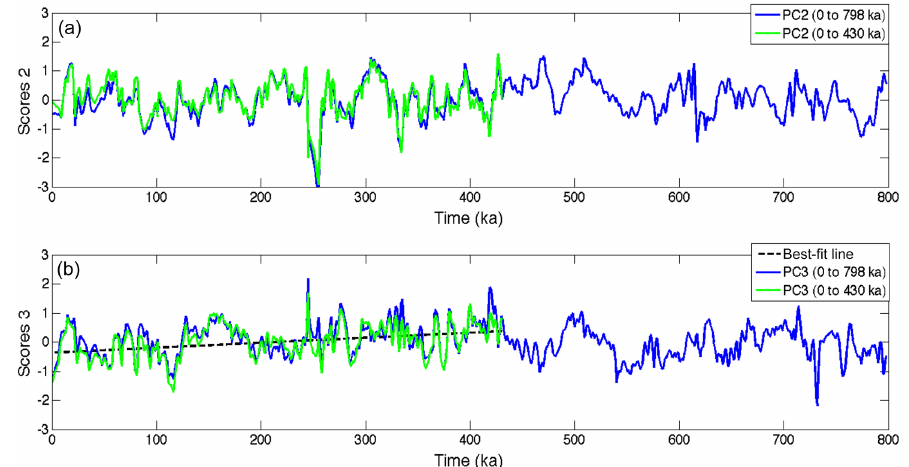
Figure 5. Second and third principal components for 0–430 and 0–798ka. (a) Scores for PC2 largely reflect the difference between Atlantic and Pacific benthic δ 18 O sw . (b) Scores for PC3 largely reflect the difference benthic and planktonic δ 18 O sw . Dashed black line marks linear trend from 0 to